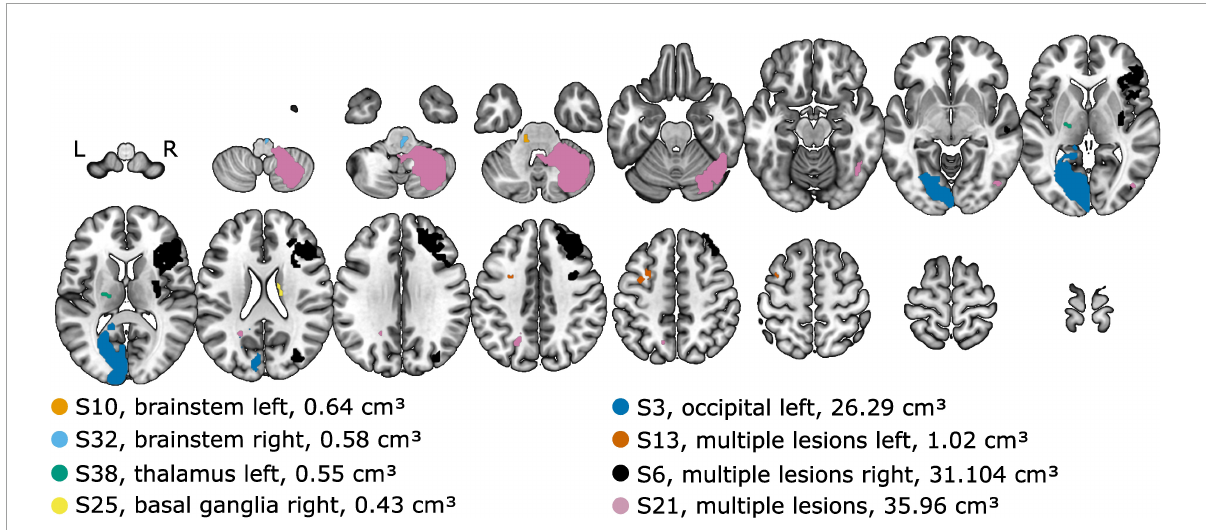
FIGURE3 Lesion locations overlaid on axial slices of the MNI152 template. The lesion group and the lesion volume is given in the legend. Selected patients are highlighted by the color coding used throughout the